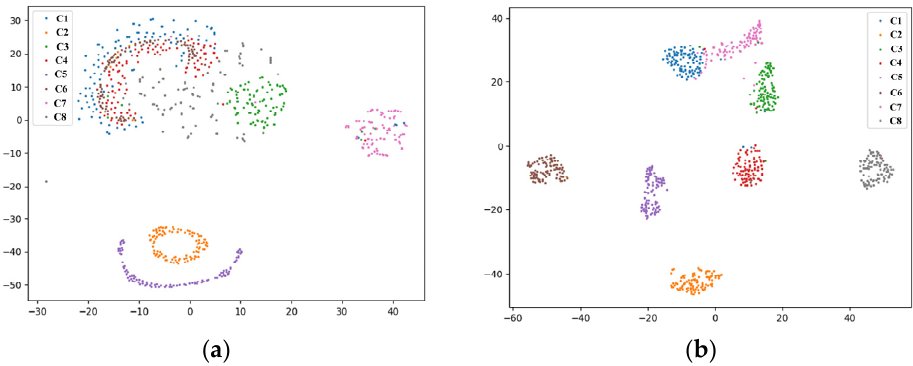
Figure 11. Confusion matrix of recognition rate.